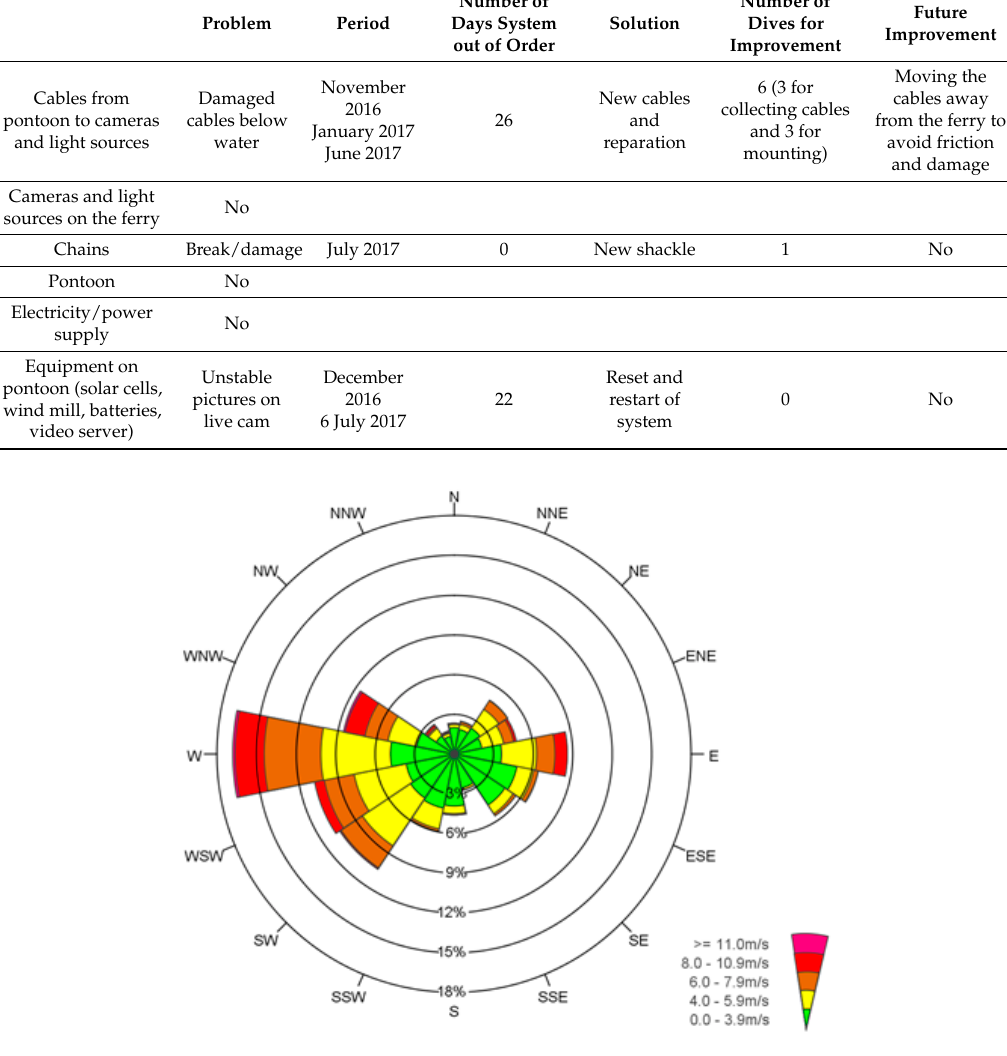
Figure 6. Mean wind, maximum wind, and the direction of the wind, measured at the local station (Sydfyns Flyveplads, station number 612400) by The Danish Meteorological Institute from September 2016 to August 2017.